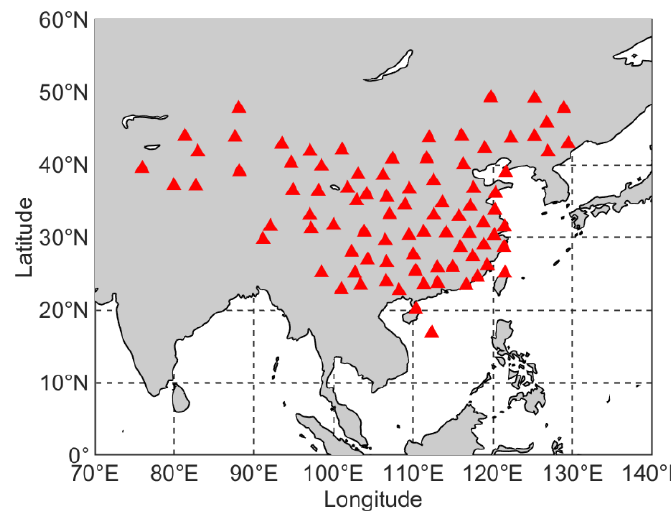
Figure 1. Geographic distribution of the 86 radiosonde stations.